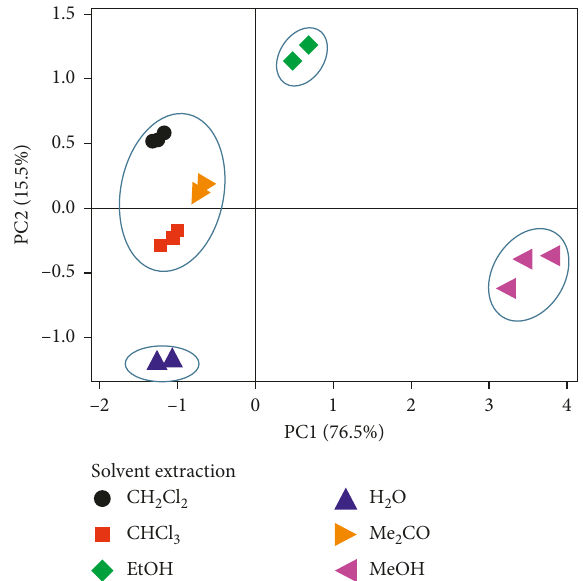
Figure 2: Principal component analysis of the content of phyto- chemical components from S. buxifolia extracted by different solvents (dichloromethane: CH 2 Cl 2 ; chloroform: CHCl 3 ; ethanol: EtOH; distilled water: H 2 O; acetone: Me 2 CO; and methanol: MeOH). PCAs show the first (PC1) and second (PC2) principal